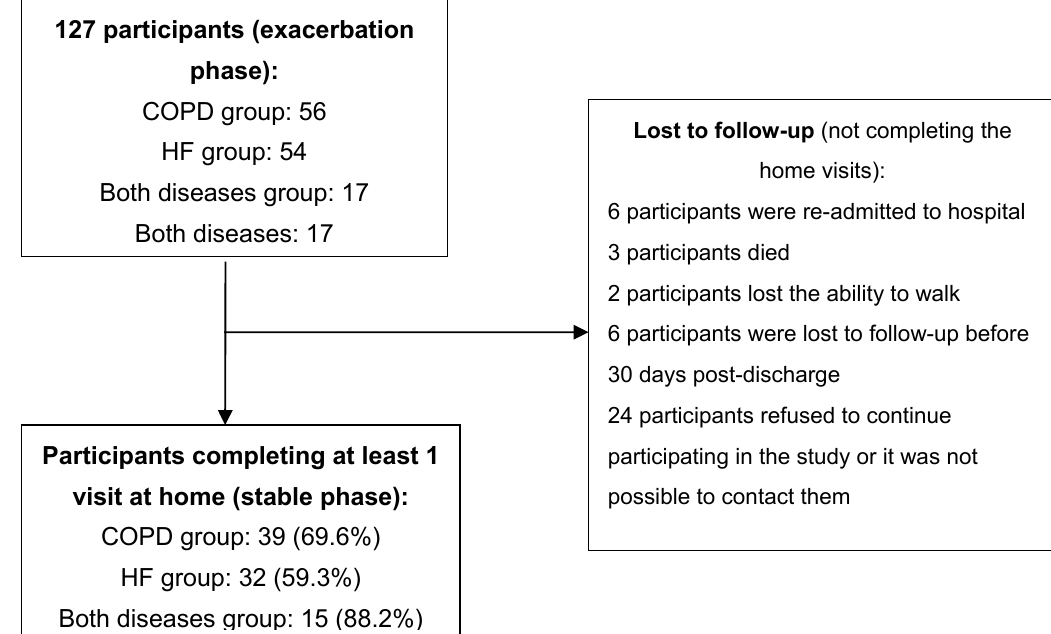
Figure 2. Participant recruiting and follow-up. Table 1. Distribution of baseline characteristics according to disease.